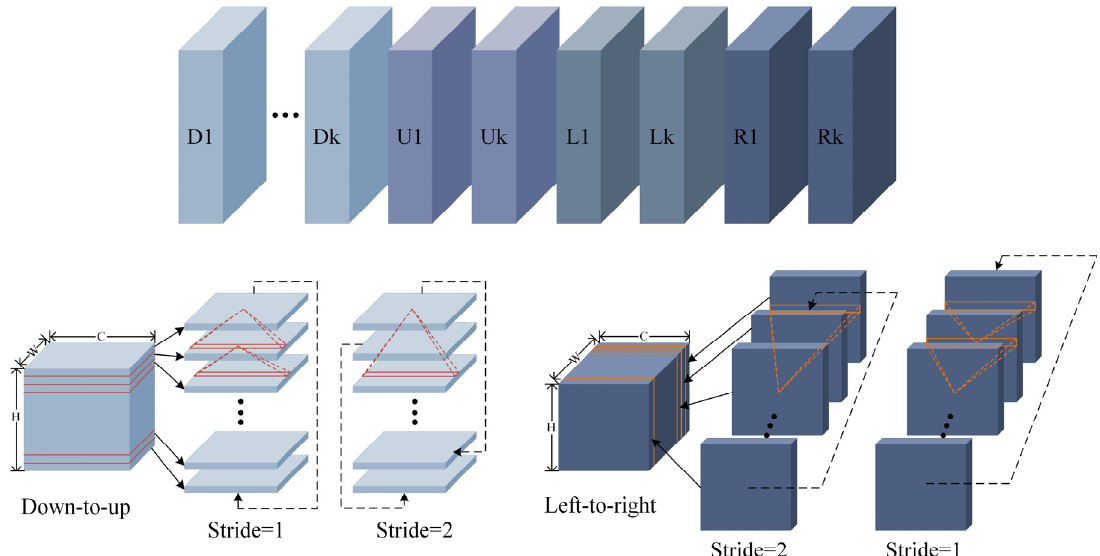
Figure 4. RESA module. D1 to Dk represent k iterations “top to bottom”, U1 to Uk represent k iterations “bottom to top”, L1 to Lk represent k iterations “right to left”, R1 to Rk represent “left to right” for k iterations. In the two modules “bottom-to-top” and “left-to-right”, information is propagated repeatedly and simultaneously at different strides.